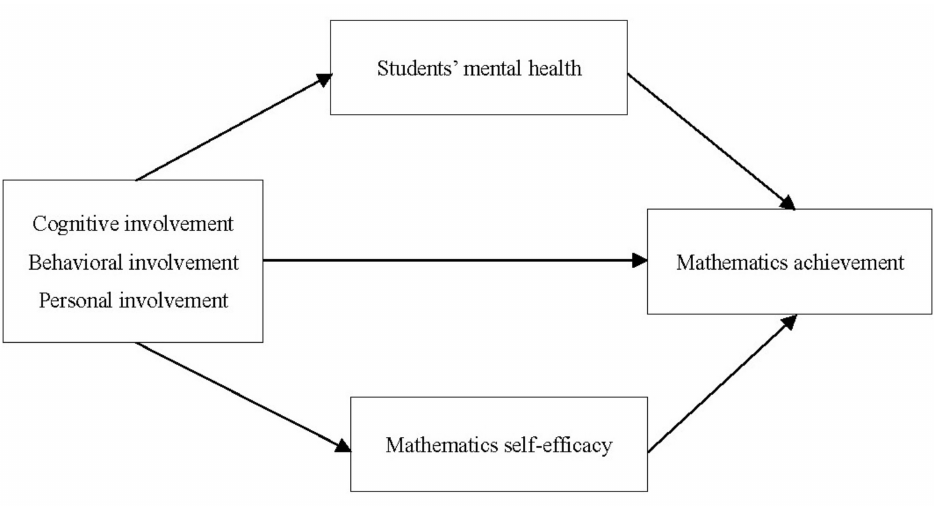
Figure 1. Hypothesized multiple mediator